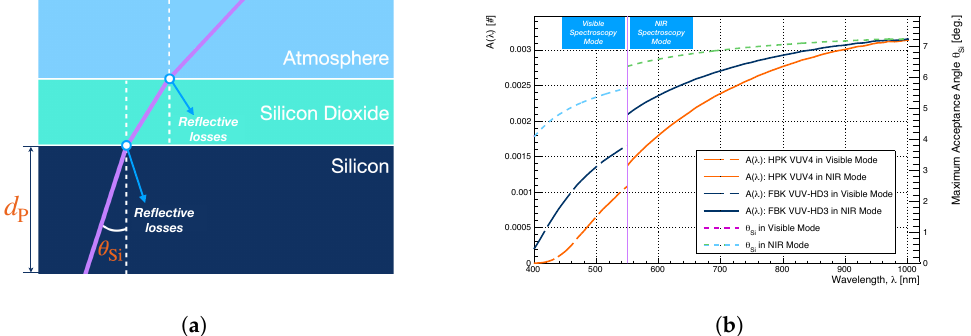
Figure 6. ( a ) Schematic representation of the SiPM surface coating structure used to compute the photon acceptance correction factor A ( λ ) . θ Si is the maximum angle for which photons emitted in the silicon can be detected by the microscope objective. d P is the depth of the avalanche region. ( b ) The photon acceptance correction factor A ( λ ) (Equation (5)) and maximum acceptance angle ( θ Si , Equation (7)) as a function of the wavelength for the two spectroscopy modes introduced in Section 2. The discontinuity in the A ( λ ) correction factor for the two SiPMs is due to the two different objective lenses (with different numerical aperture) used in the Visible (LMPLFLN20X) and NIR (LCPLN20XIR) spectroscopy measurement modes as shown in Section 2.